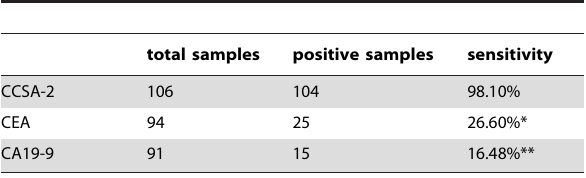
Table 4. Compared the use of CCSA-2 with CEA or CA19-9 to detect colorectal cancer.